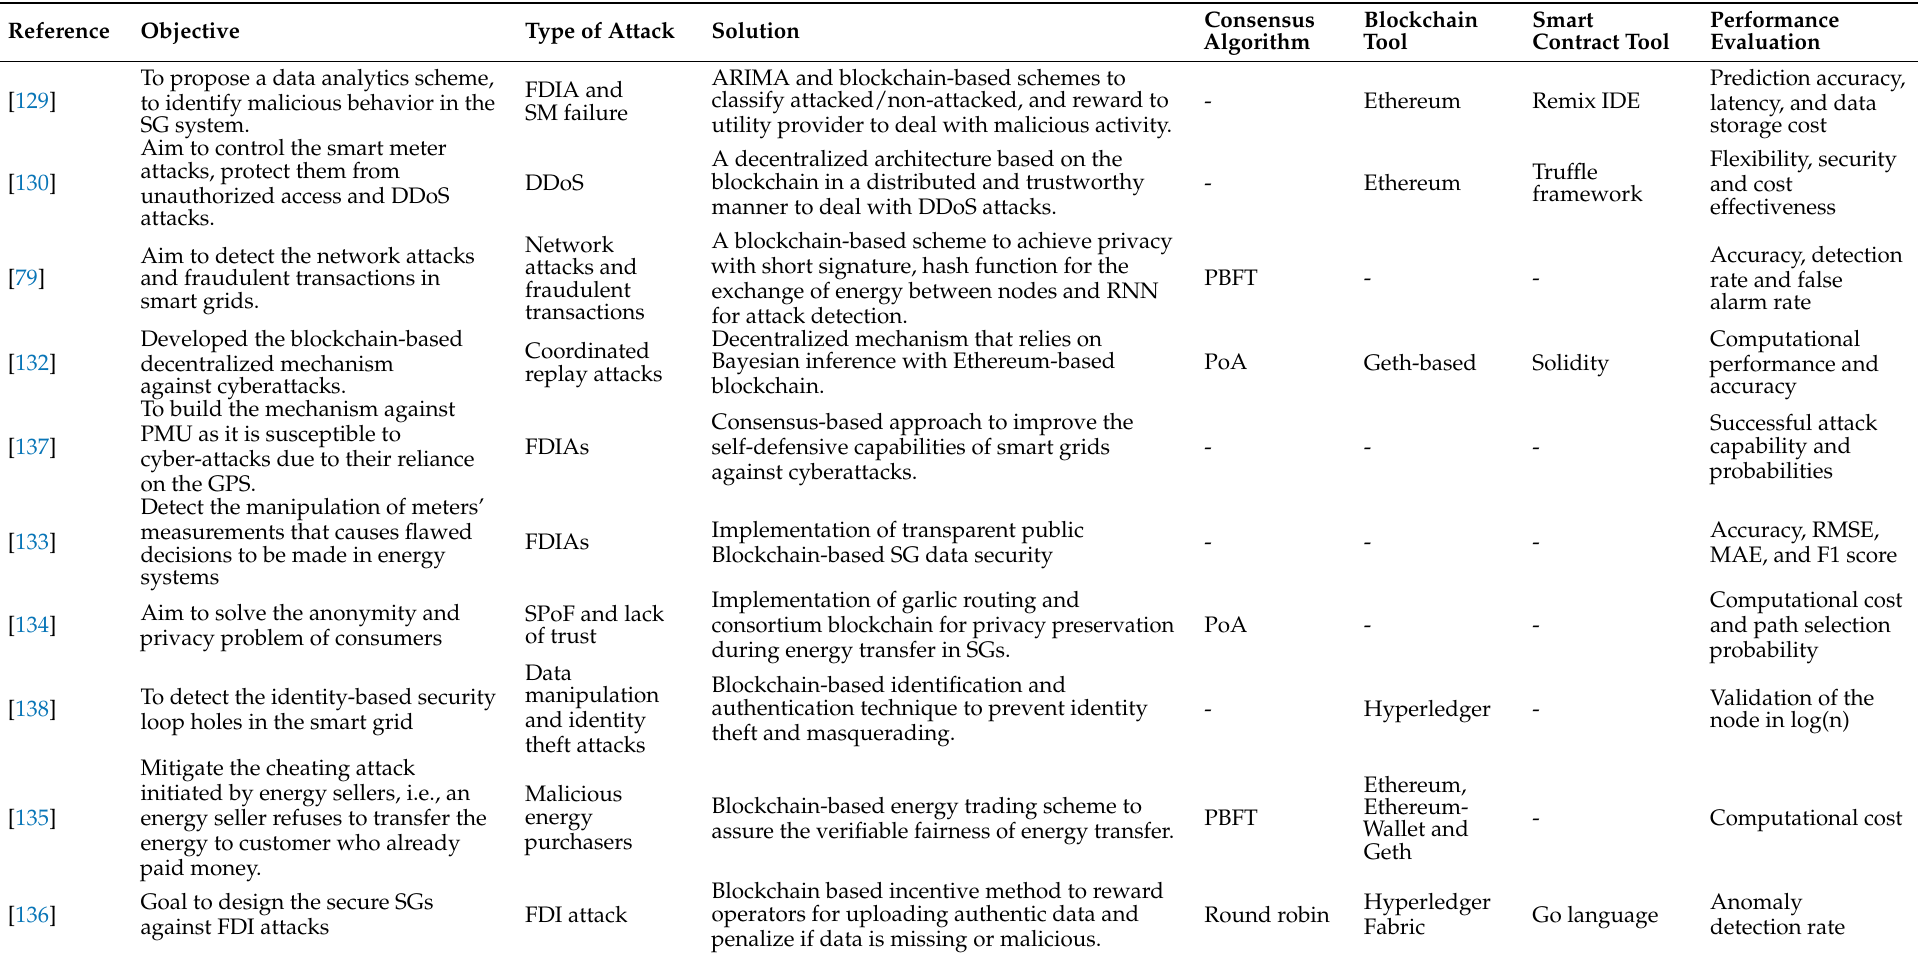
Table 10. Blockchain based attack detection techniques for cybersecurity in smart